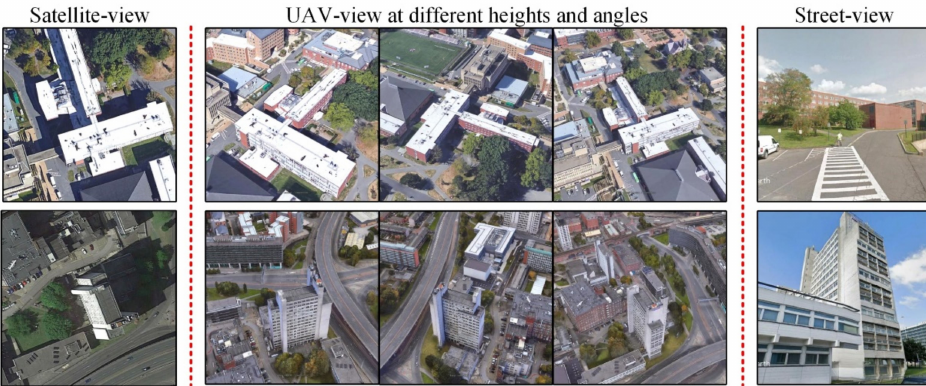
Figure 1. The images of different views from University-1652 (the left column, the middle column, and the right column are satellite-view images, unmanned aerial vehicle (UAV)-view images, and street-view images, respectively).